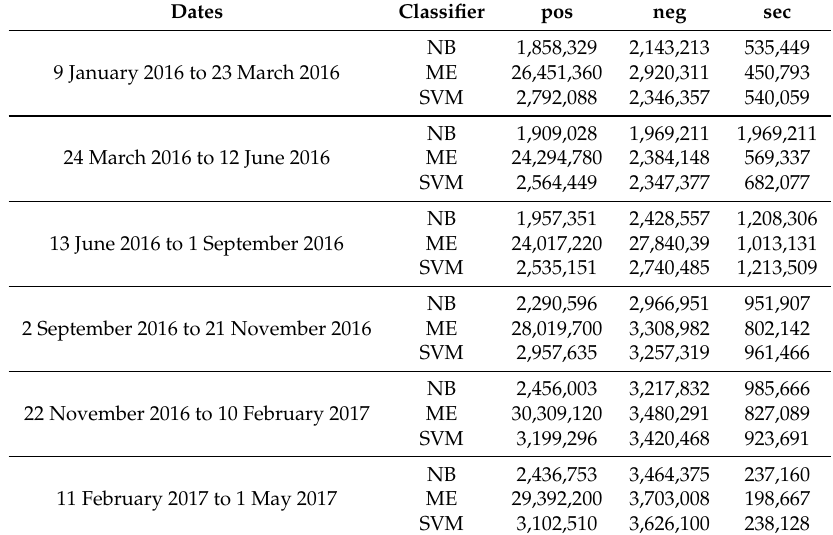
Table 5. Classified tweets over 486